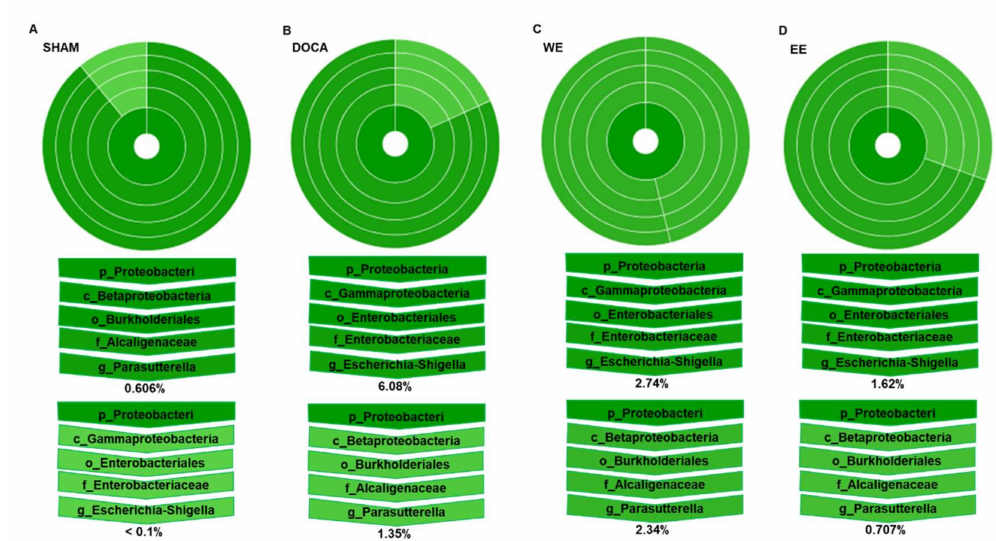
Figure 6. Effect of water extract and ethanol extract of L. rhamnosus AC1-fermented soymilk on the microbial composition belonging to phylum Proteobacteria at week 14. Percentage of community abundance in SHAM ( A ), DOCA ( B ), WE ( C ) and EE ( D ).